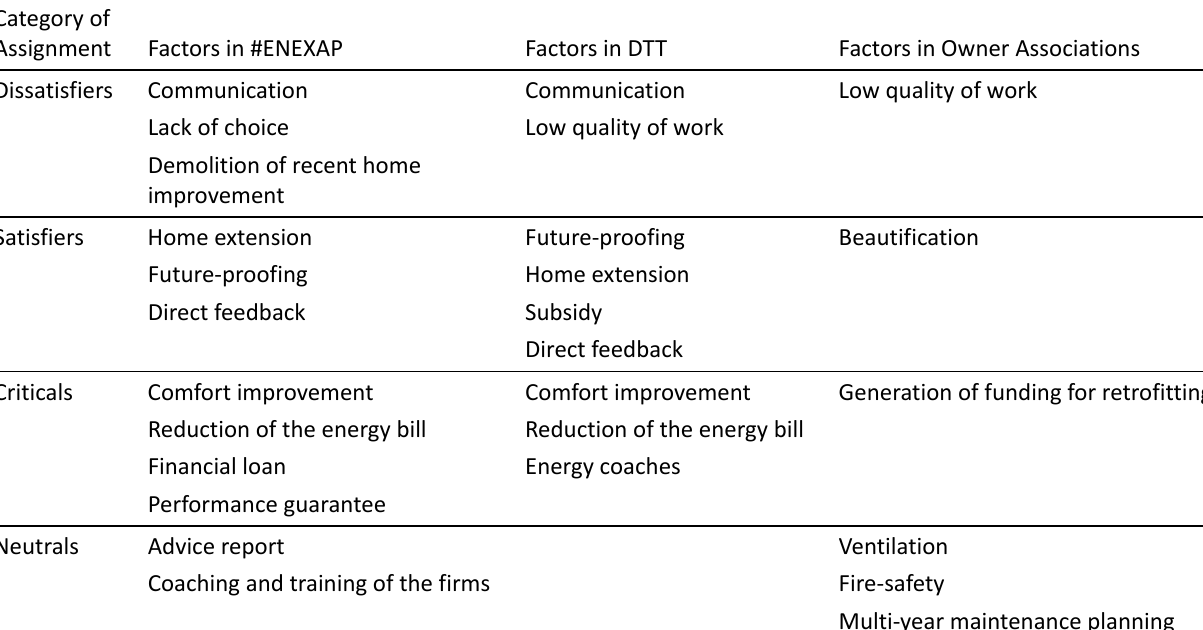
Table 5. Dissatisfiers, satisfiers, criticals, and neutrals in the perception of owner‐occupants. Category